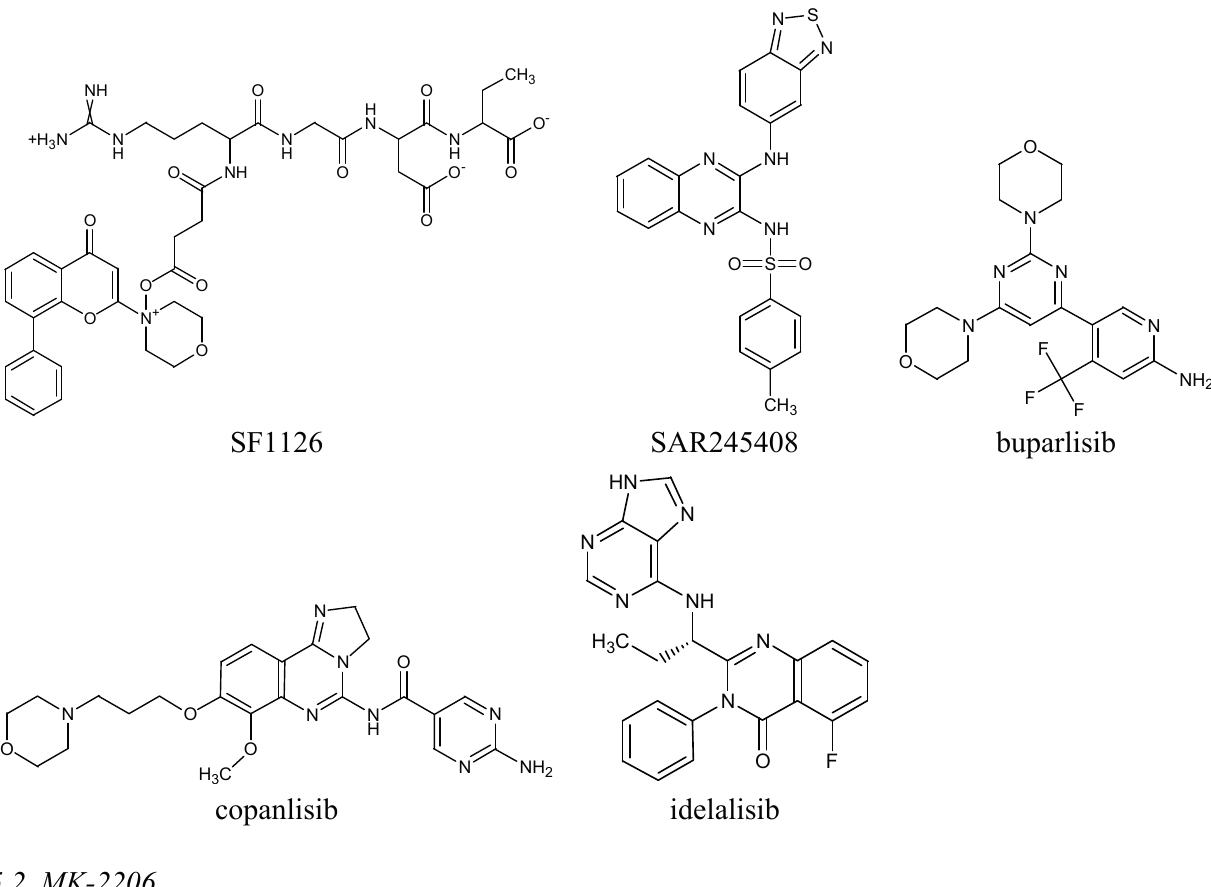
Figure 2. Chemical structures of phosphoinositide 3-kinase (PI3K) inhibitors with potential activity in diffuse large B-cell lymphoma.